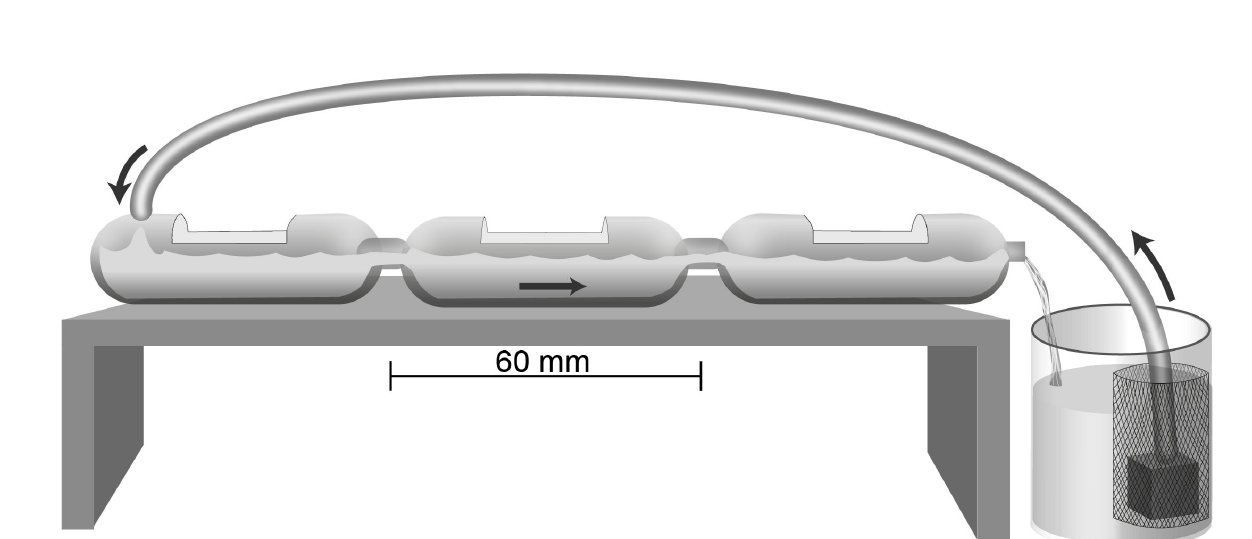
Figure 1. Scheme of the three-compartment assay chamber to evaluate drift by the benthic estuarine microalgae Cylindroteca